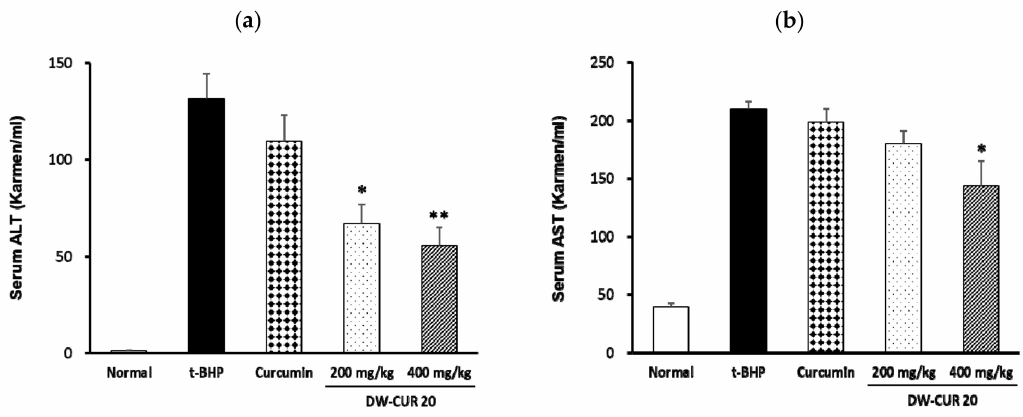
Figure 7. E ff ects of DW-CUR 20 on serum biochemical parameters. ( a ) Alanine aminotransferase (ALT) and ( b ) aspartate aminotransferase (AST) levels in t-BHP-induced hepatotoxicity in mice. Data were expressed as mean ± SE ( n = 6). * p < 0.05, ** p < 0.01 compared to the t-BHP